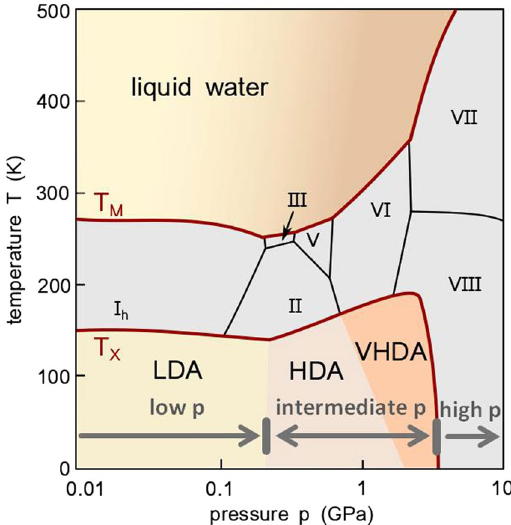
Figure 1. Phase diagram of water including the range of observation for metastable amorphous ices. The area of stability for the crystalline phases is bordered by the melting line T M at higher temperatures and the crystallisation line of the amorphous solid phases T X at low temperatures. LDA is mostly found in the low- pressure region of the phase diagram (0–0.2 GPa), HDA and VHDA in the intermediate-pressure region (~0.2–2 GPa). At high pressures ( > 2 GPa) only crystalline phases are stable. Adapted from 43